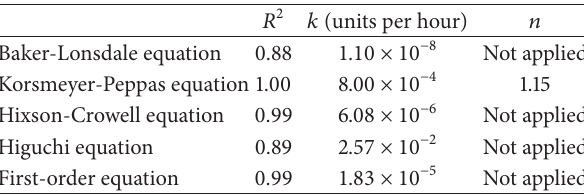
Table 1: Kinetic parameters of equations for mechanism of release 5